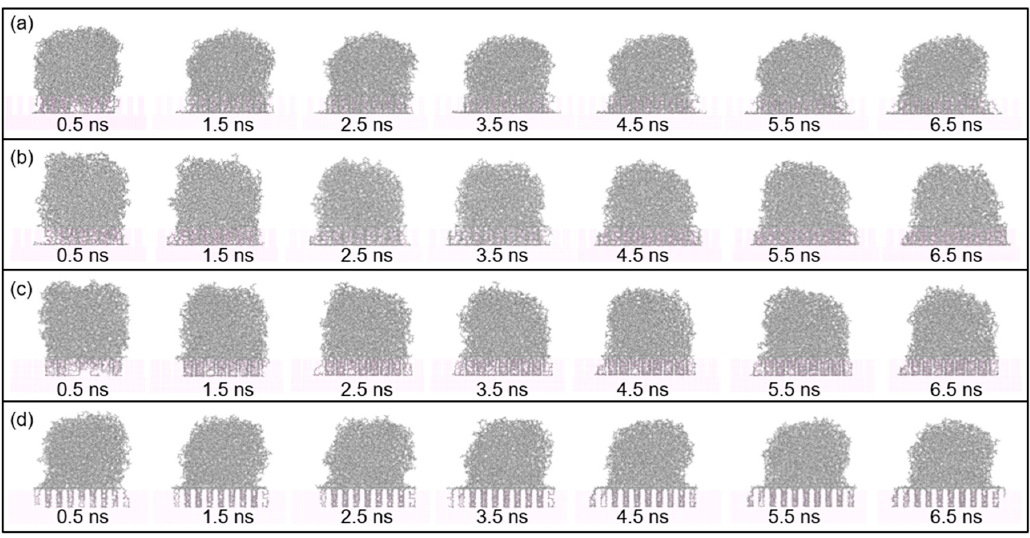
Figure 5. Snapshots of the spreading process of PP droplet with simulation time on Al substrate with rough surface. The side length of the column array was ( a ) 0.40 nm, ( b ) 0.64 nm, ( c ) 0.81 nm and ( d ) 1.21 nm respectively.